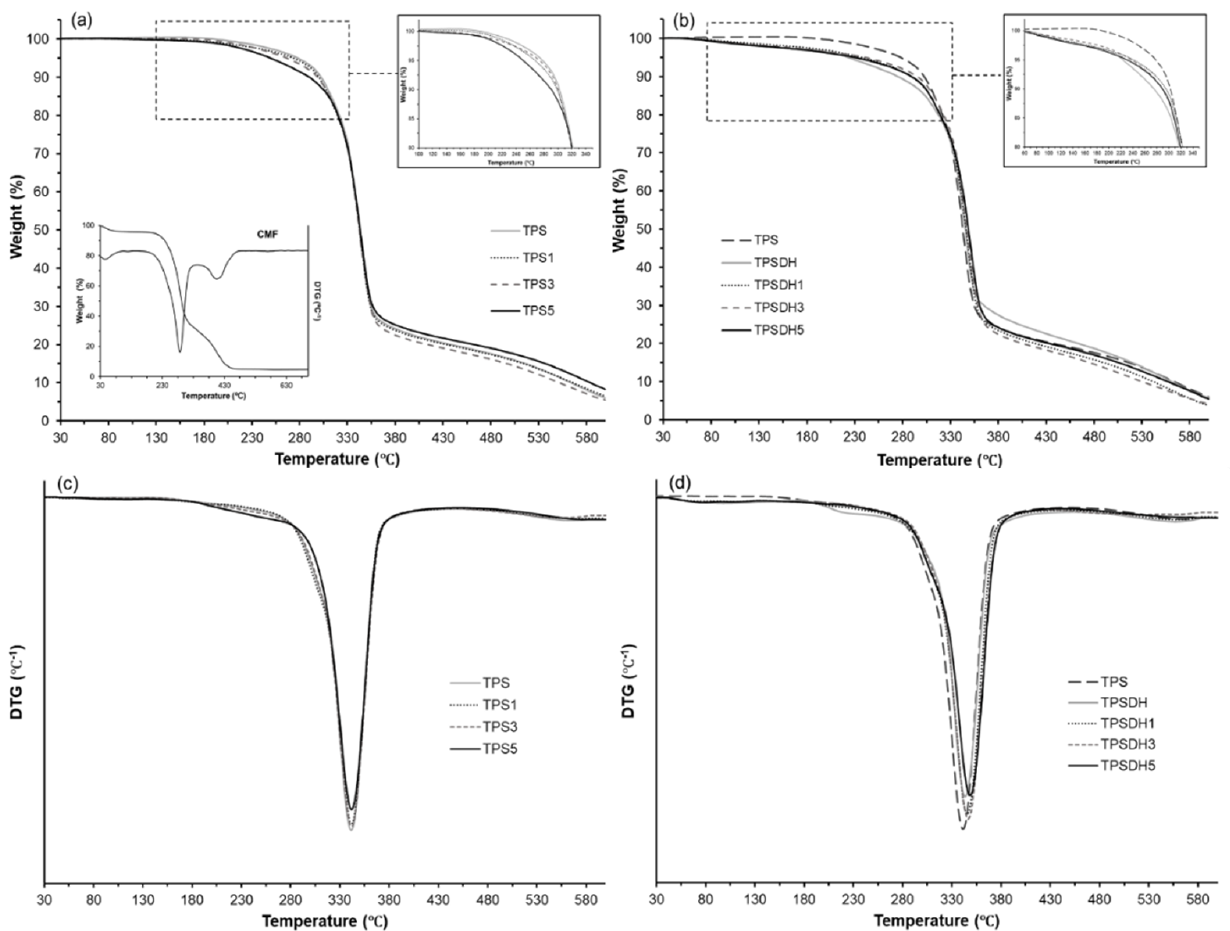
Figure 6. Thermogravimetric analysis (TGA) curves ( a , b ) and first derivative (DTG) curves ( c , d ) curves of thermoplastic